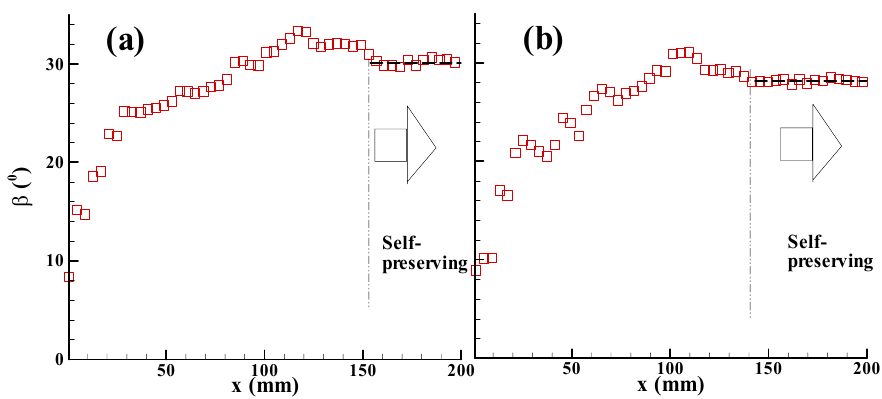
Figure 6 Stream-wise evolution of the inclined angle of the joint PDF at η = 0 under two = (a) 624, (b) conditions of R = 0.67 and Re θ